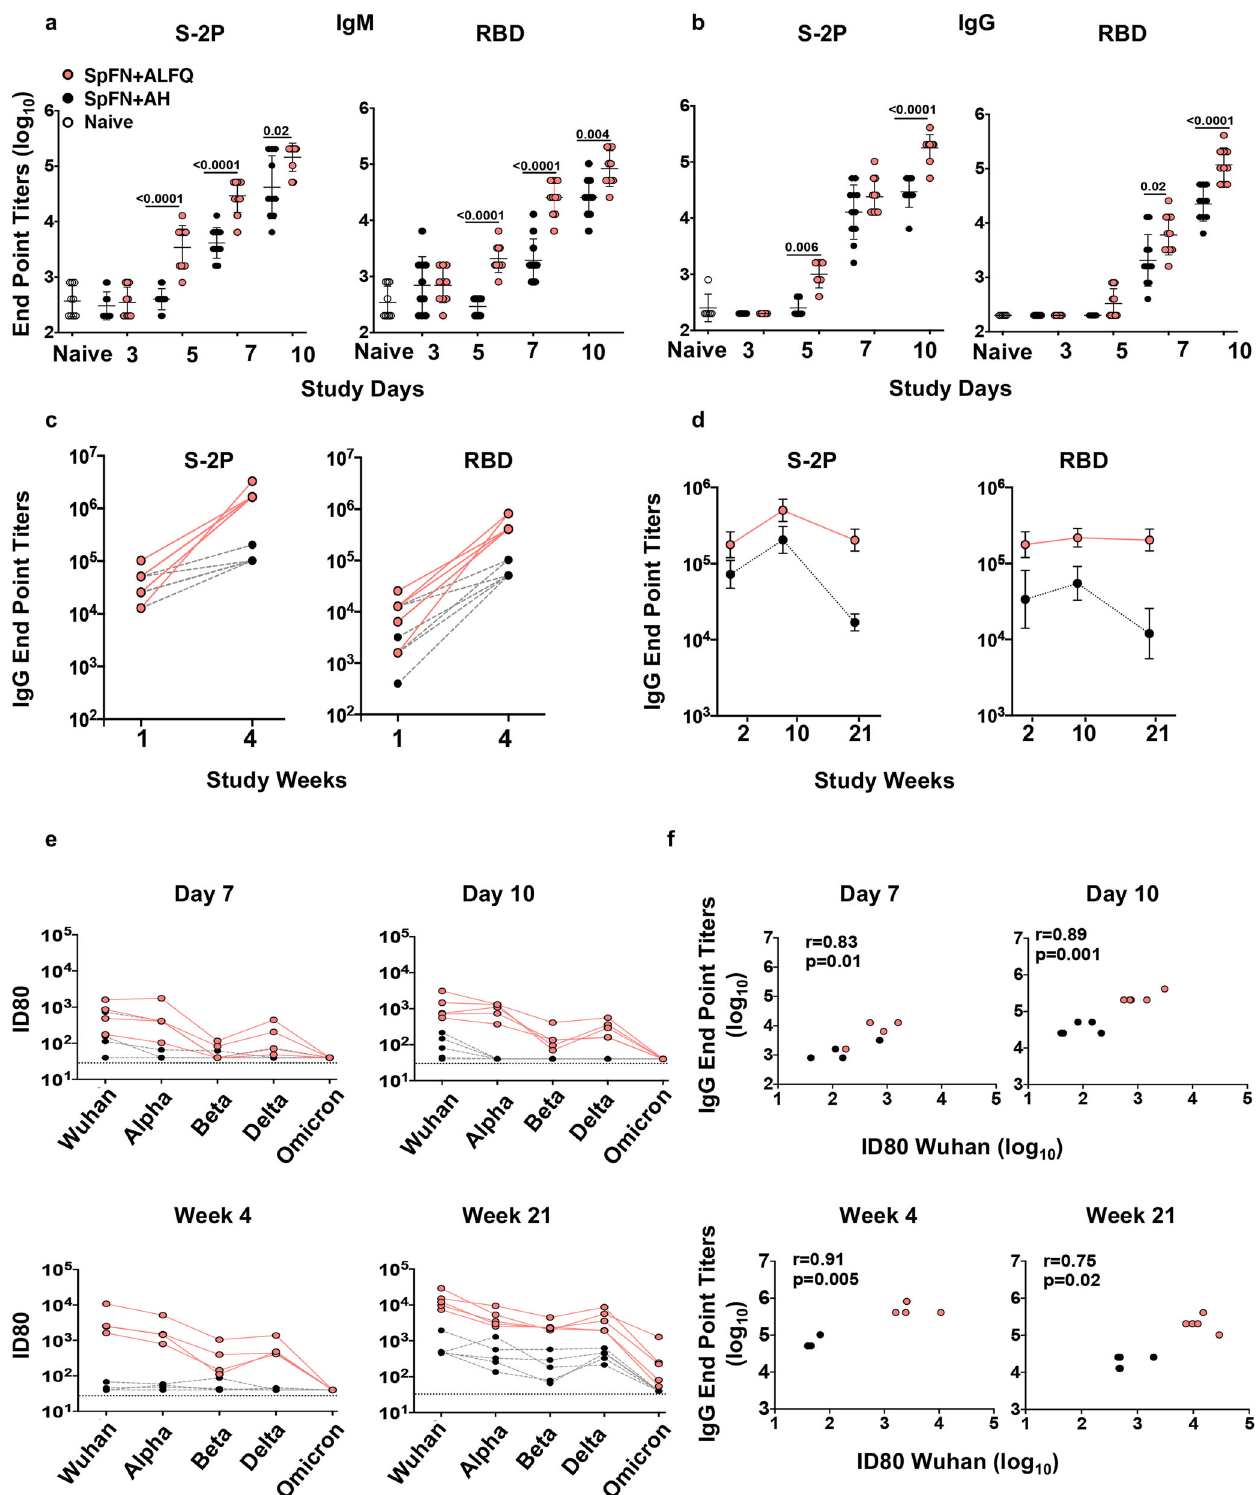
cytometer (Cytek Biosciences). The data were analyzed using FlowJo software v10.7.1 (BD Biosciences). Approximately, 1 × 10 6 fresh splenocytes were plated in a U-bottom plate and stimulated with SARS-CoV-2 spike protein peptide pool from JPT (S-2P, 1 μ g/ml). The plates were incubated at 37 °C, 5% CO 2 for 2 h followed by the addition of